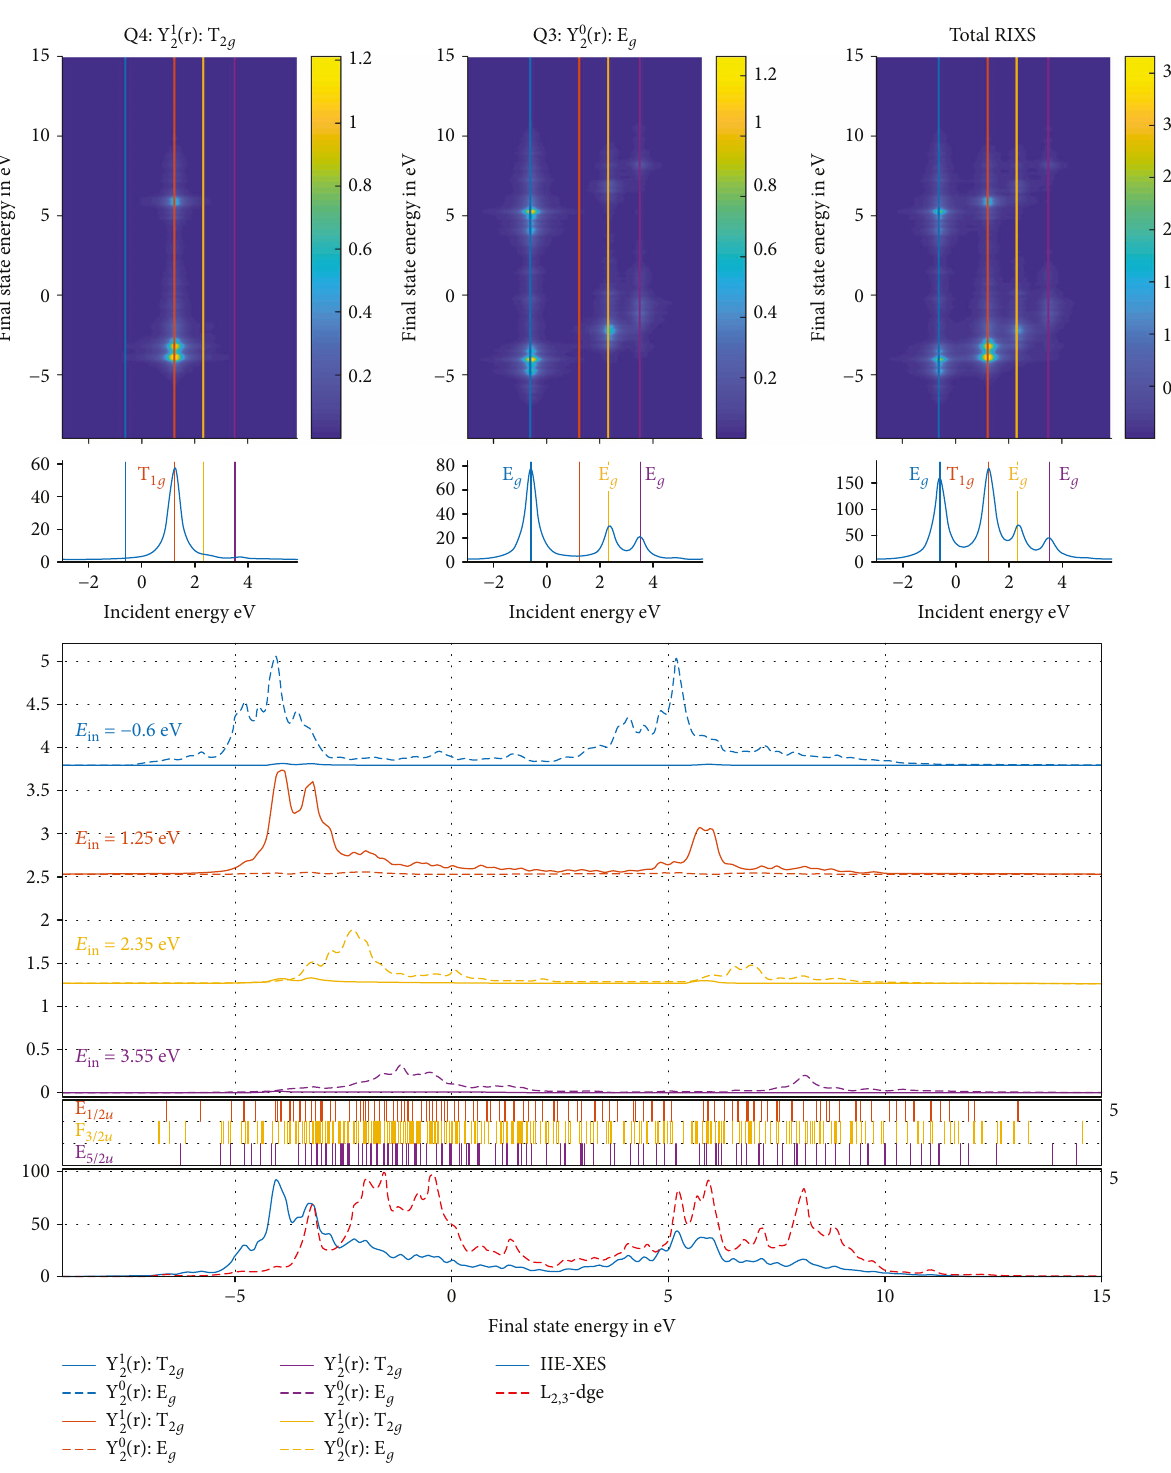
Figure 30: Calculated 1s2p RIXS spectrum for 3d 3 Cr 3+ for 10D q = 1 5eV